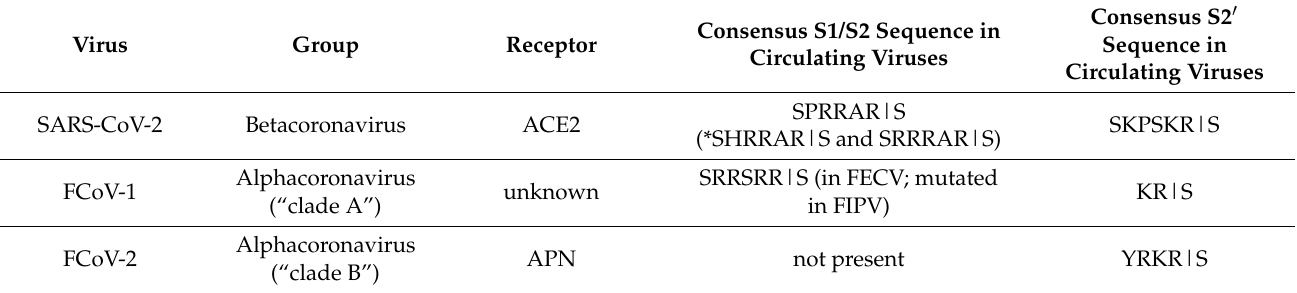
Table 1. Summary of SARS-CoV-2 and the two FCoV serotypes. The spike glycoprotein of coro- naviruses, mediated by proteolytic cleavage, is the main driver of cellular receptor binding and membrane fusion. The taxonomic classification, host receptor, and S1/S2 and S2 (cid:48) proteolytic cleavage site amino acid sequences are summarized